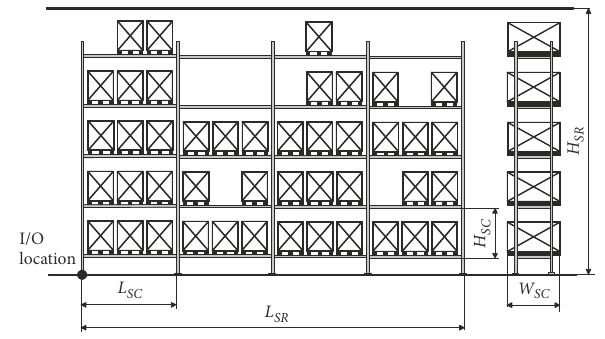
Figure 3. The SR with storage compartments – side view (Lerher et al. 2013)